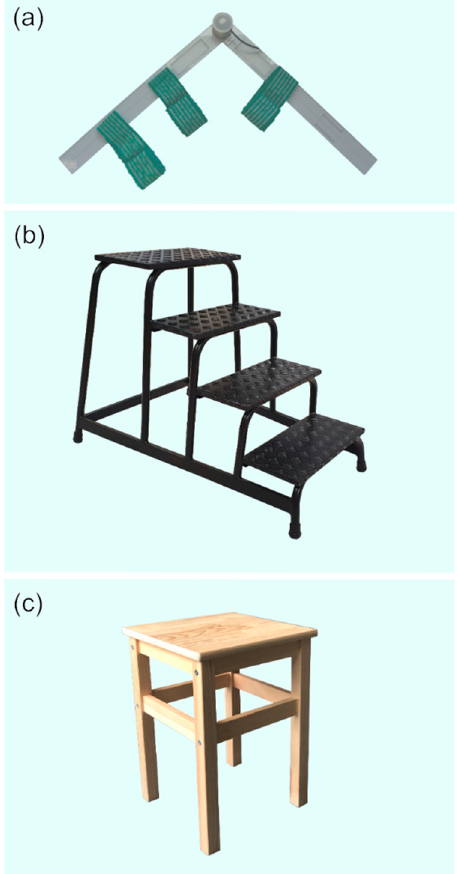
Figure 3. ( a ) Additional goniometer used during the calibration process, with Velcro straps and transparent lever arms that enabled positioning along anatomical lines, ( b ) portable aluminum staircase used for stair ascend and stair descend, ( c ) armless wooden stool used for sitting down and getting